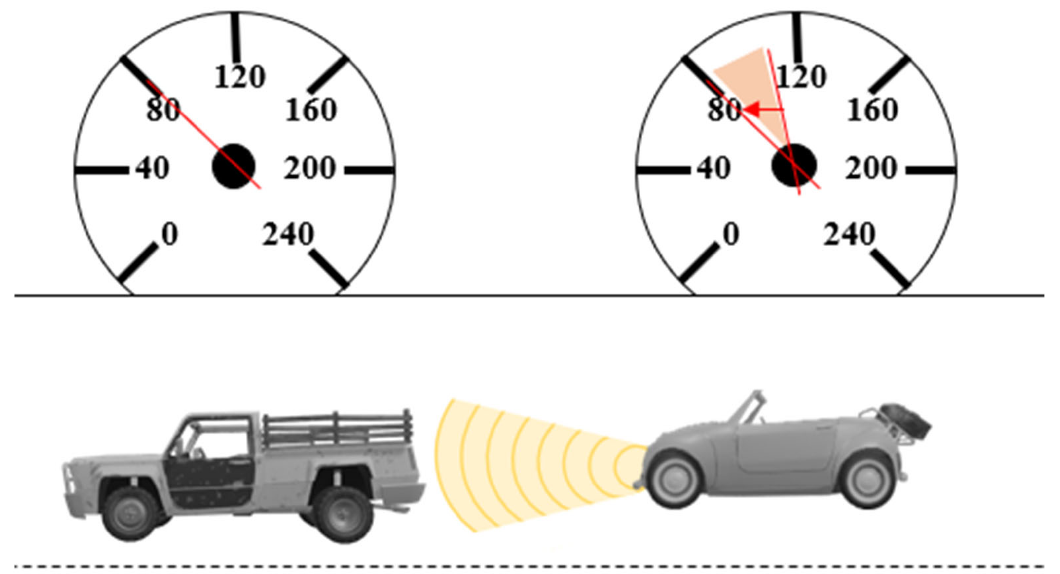
Figure 3. ACC showing selected maximum speed and time gap setting.